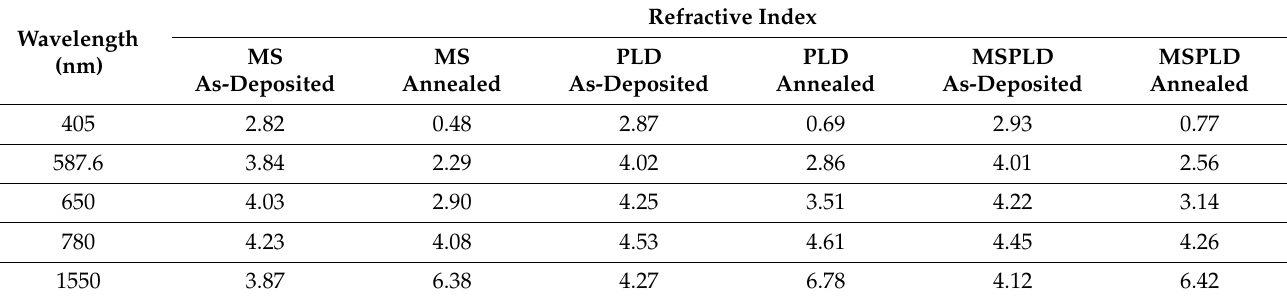
Table 4. Refractive indices ( ± 0.03) of the as-deposited and annealed Ge 2 Sb 2 Te 5 thin films.